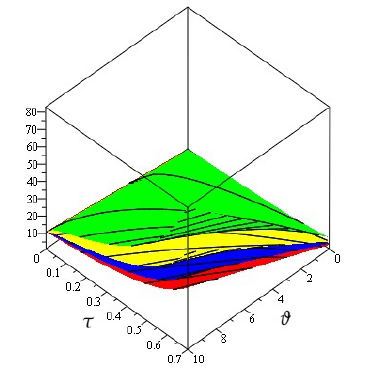
Figure 6. The different fractional-order of (cid:36) of ν ( ϑ , ζ , z , τ ) of Example